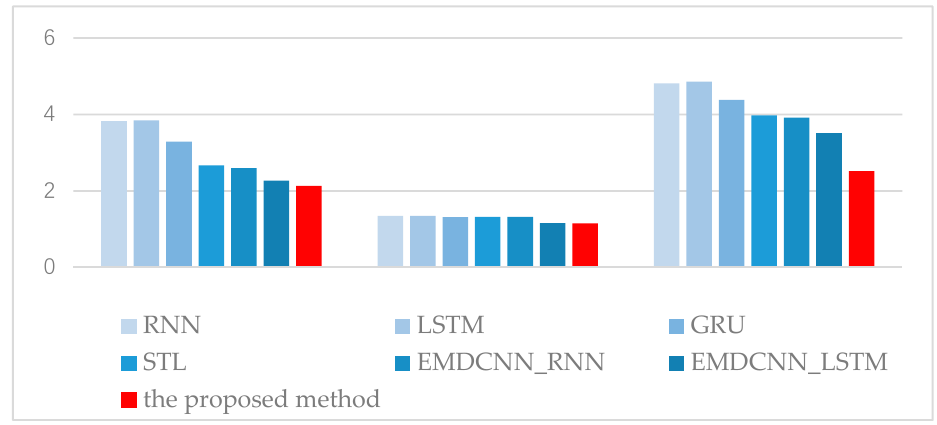
Figure 8. Histogram of RMSE values for predictions of temperature, wind speed, and humidity.